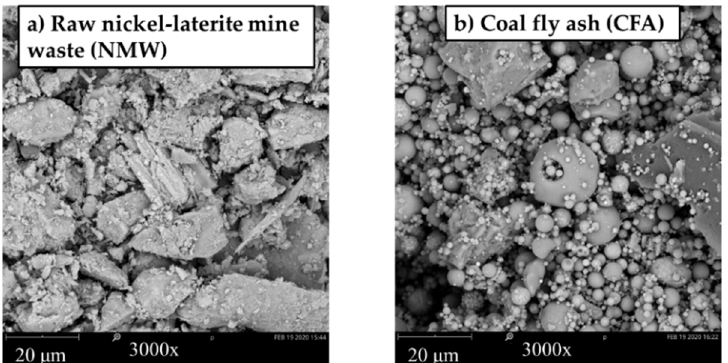
Figure 3. SEM images at magnification 3000× for ( a ) raw nickel–laterite mine waste and ( b ) coal fly